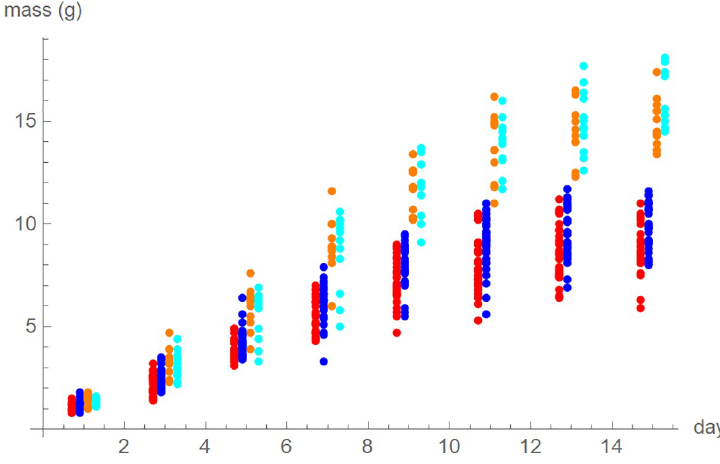
Fig 2. Mass at days 1, 3, ... , and 15 plotted side-by-side; from left female blue tits (red), male blue tits (blue), female great tits (orange), and male great tits (cyan).